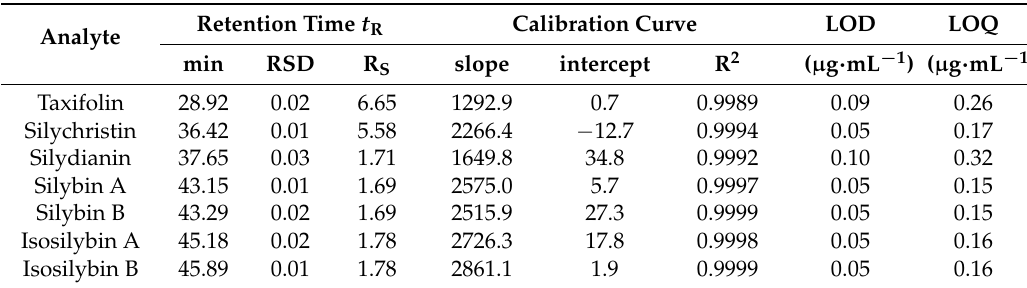
Table 1. Calibration function parameters for the different analytes using UV detection.